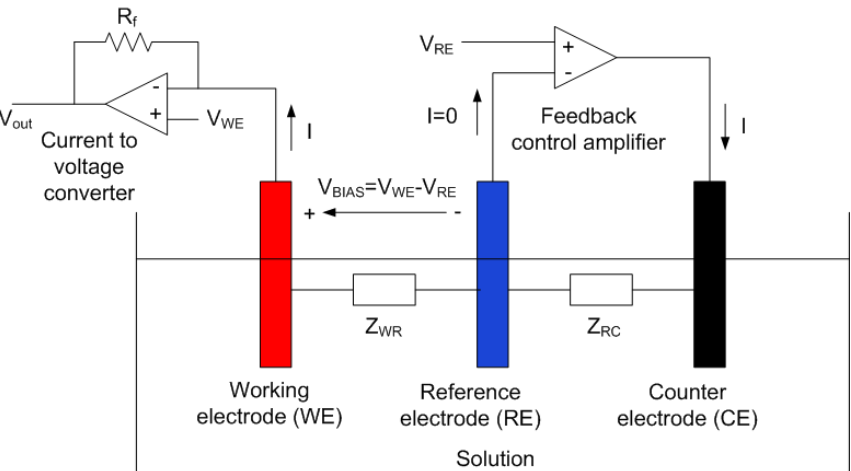
Figure 1. Schematic of a potentiostat, with the electrochemical cell modeled by two equivalent circuits with their respective